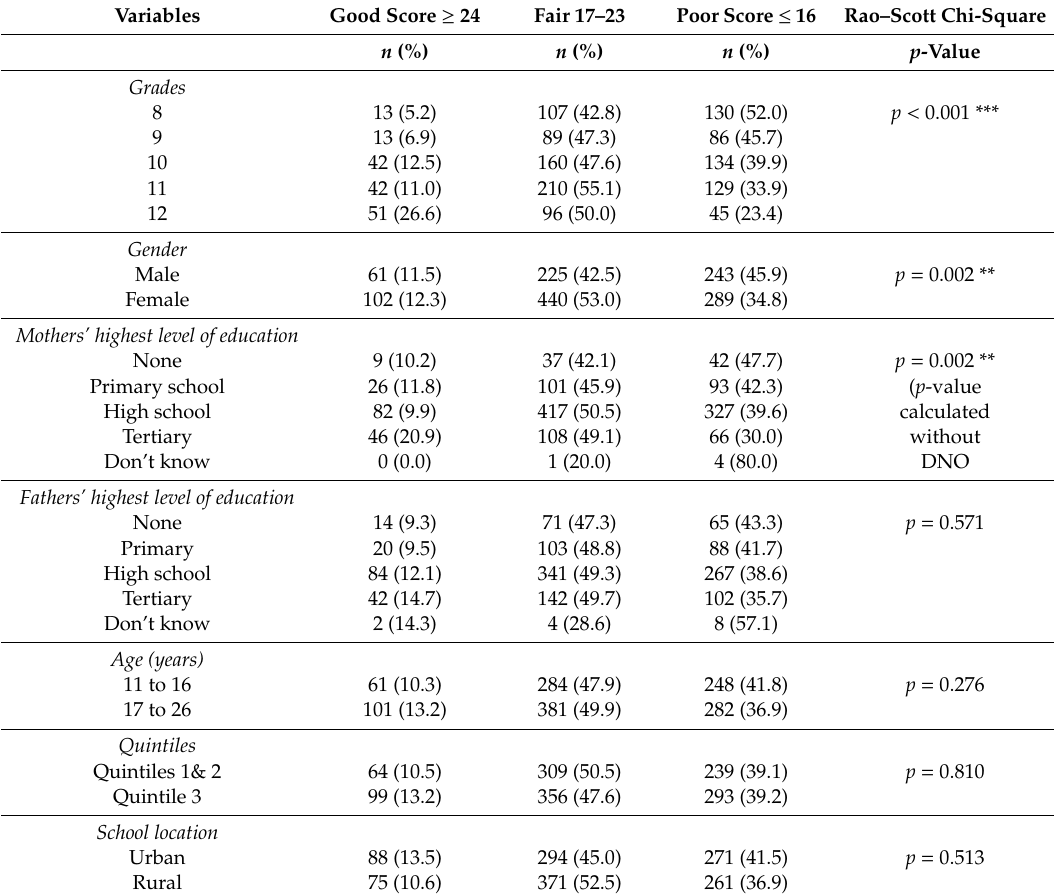
Table 6. Nutrition knowledge of learners by demographic